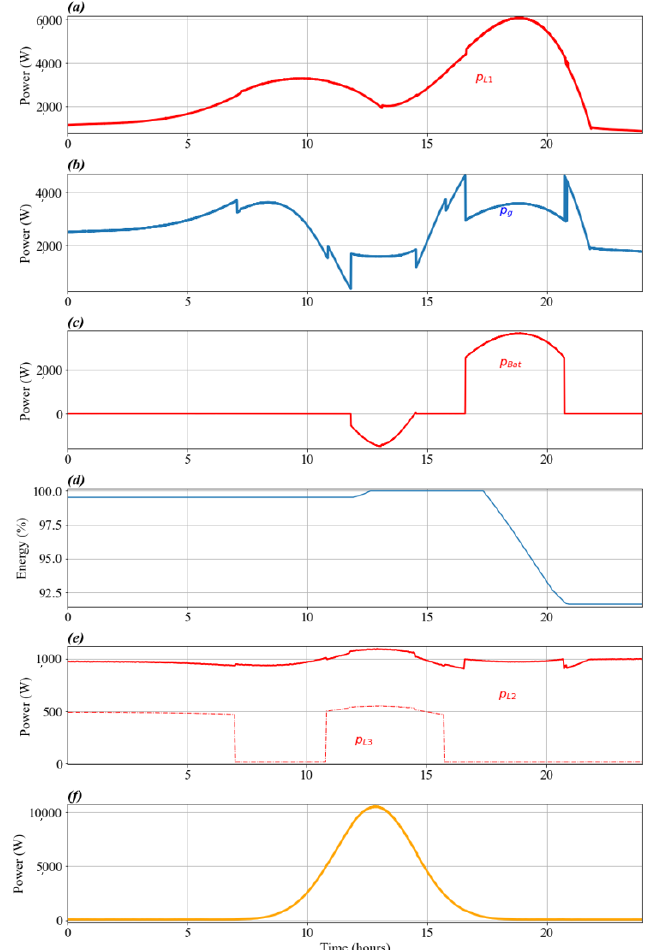
Figure 23. MG operating in connected mode with bus abundance of active power. Power values: ( a ) Main load active power; ( b ) Main grid active power; ( c ) Battery bank active power; ( d ) Battery storage level; ( e ) Load 2 and 3 active power; ( f ) Photovoltaic active